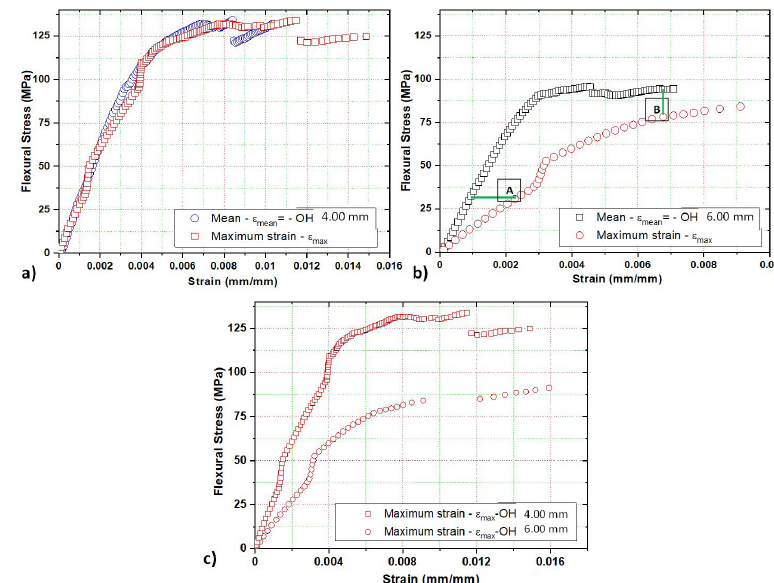
Figure 4. Comparison of mean strain and maximum